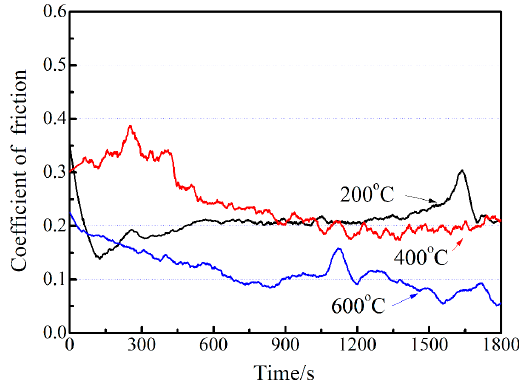
/ a-Si:H films under di ff erent Figure 8. CoF of ZrO 2 ball/a-Si:H films under different temperatures. Figure 8. CoF of ZrO Figure 8. CoF of ZrO 2 ball/a-Si:H films under different temperatures. 2 ball